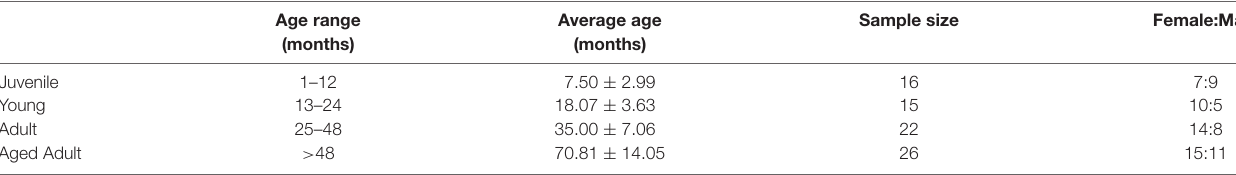
TABLE 1 | Age and gender of degus that underwent clinical ocular